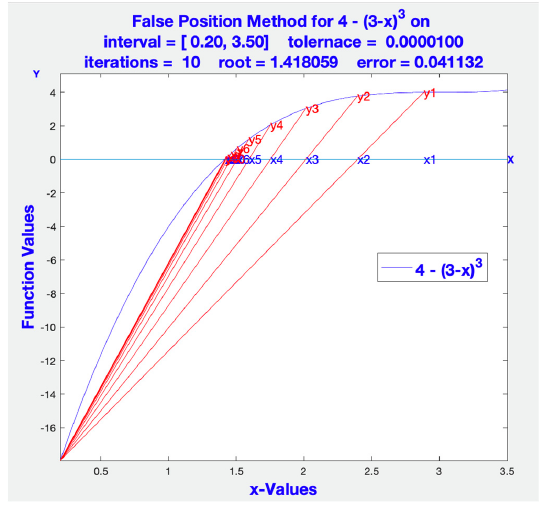
Figure 2. Convex function concave up, left endpoint fixed. Mathematics 2019 , 7 , 1118